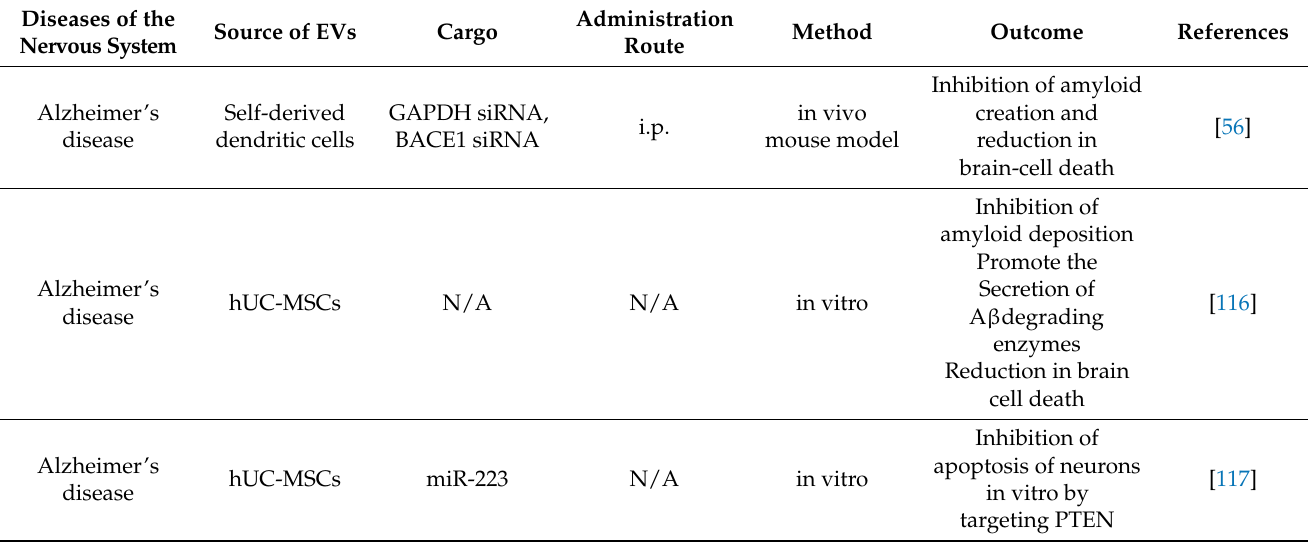
Table 3. EVs in neurological